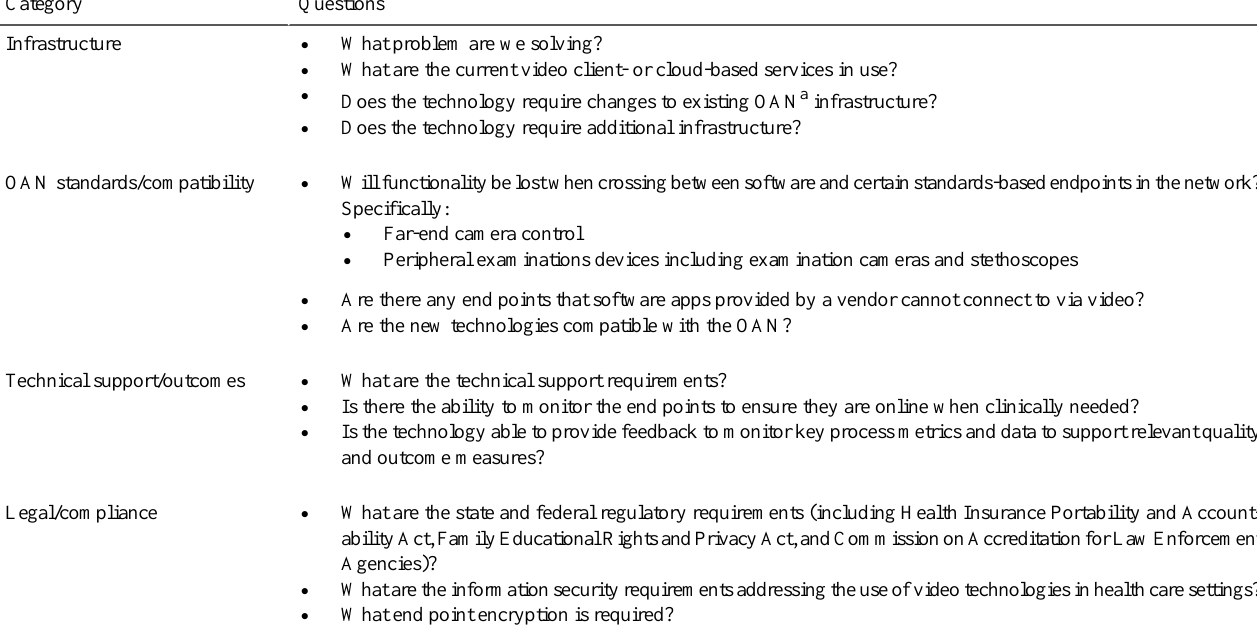
Table 2. Questions to consider when evaluating technologies for users of the open access